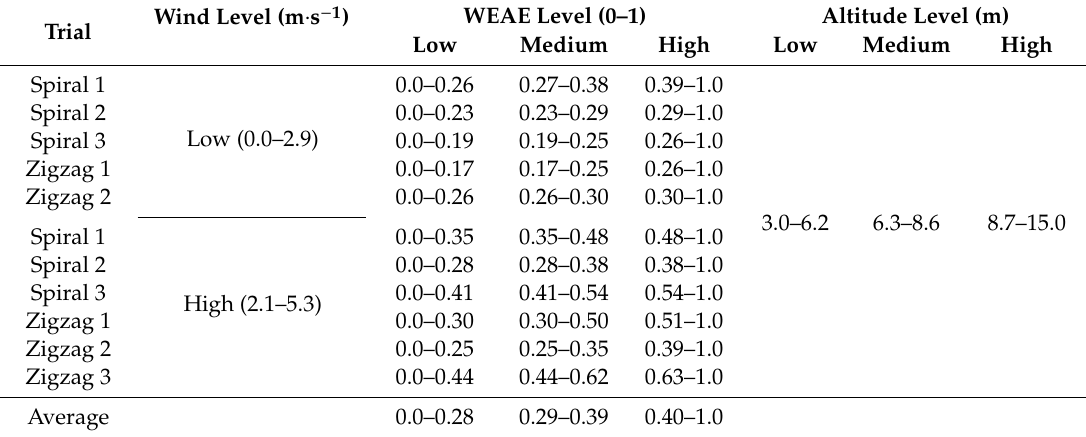
Table 2. Summary of the experimental ranges obtained after categorization of gas measurements (WEAE Level) and altitude (Altitude Level). Separation of the data was done with the function qcut from the Pandas library in